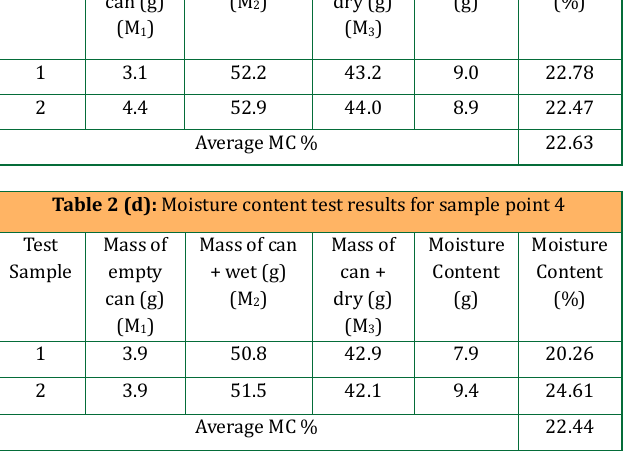
Table 2 (e): Moisture content test results for sample point 5 Test Mass of Sample